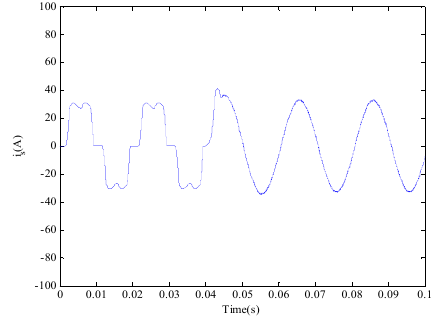
Figure 5. The improved source current of A phase.